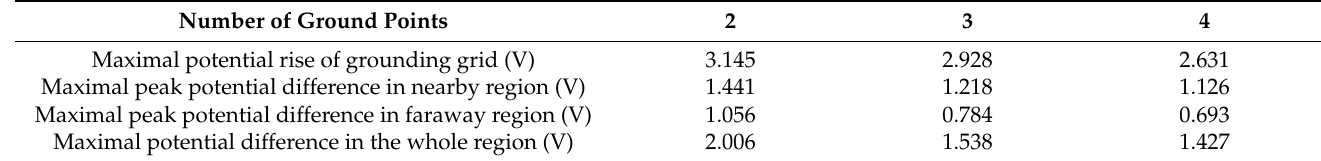
Table 3. Potential distribution of grounding grid with different numbers of grounding